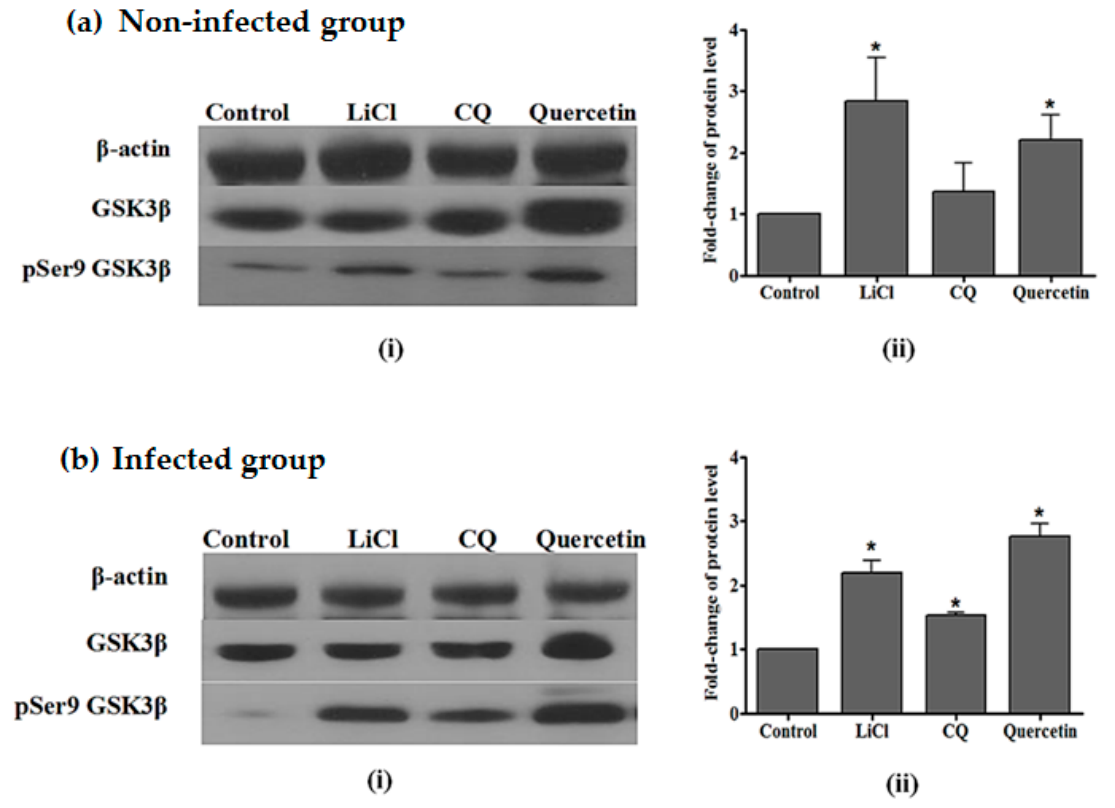
Figure 2. ( a ) (i) Intensity of immunoreactive bands for pSer9 GSK3 β and GSK3 β (ii) Fold change of phosphorylated protein levels in liver of non-infected mice; ( b ) (i) Intensity of immunoreactive bands for pSer9 GSK3 β and GSK3 β (ii) Fold change of phosphorylated protein levels in liver of mice infected with P. berghei NK65 treated with LiCl, CQ, or quercetin for four days. Total GSK3 β protein expression levels were normalised to β -actin, and pGSK3 β was normalised to total GSK3 β protein level. Densitometric measurements are illustrated as mean (fold) ± SD of corresponding measurements in non-treated controls. Significant differences between test and control groups were measured at p < 0.05 (*).